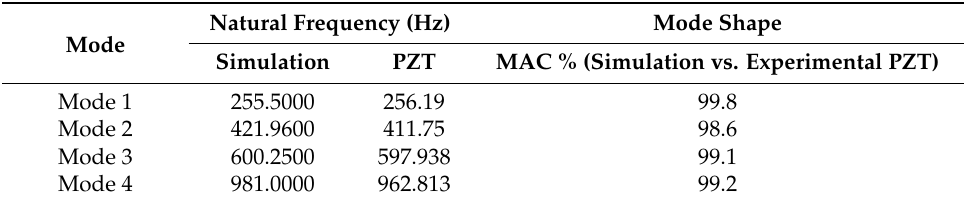
Figure 12. ( a ) Simulation model including the position of the force and the measurement point; and ( b ) application of the harmonic response compared to experimental result for the 3rd mode.